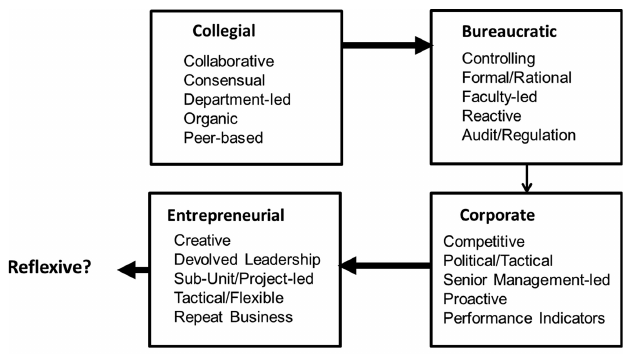
Figure 1. HEI management